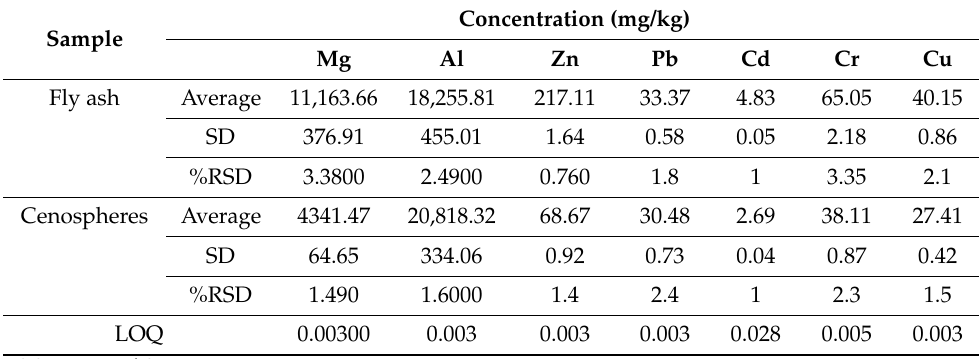
Table 3. Environmentally available concentrations of metal elements extracted from fly ash and cenospheres by acid